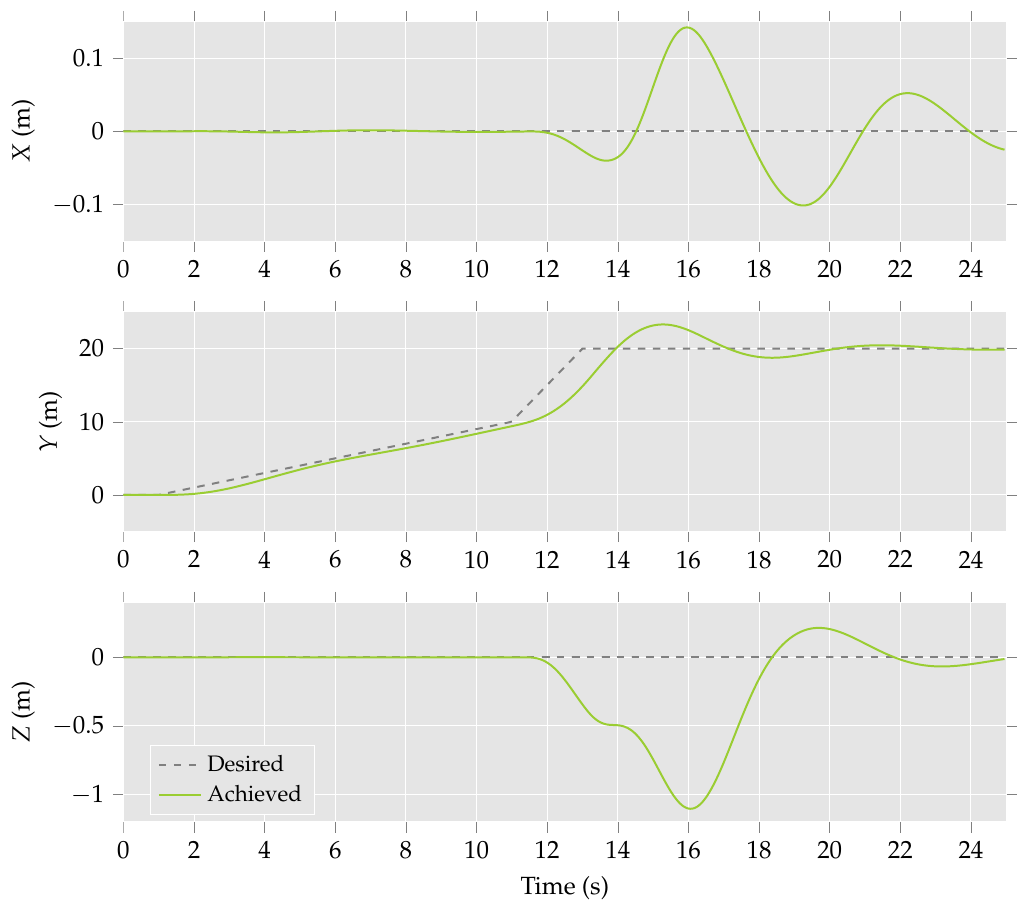
Figure 5. Multirotor helicopter position.